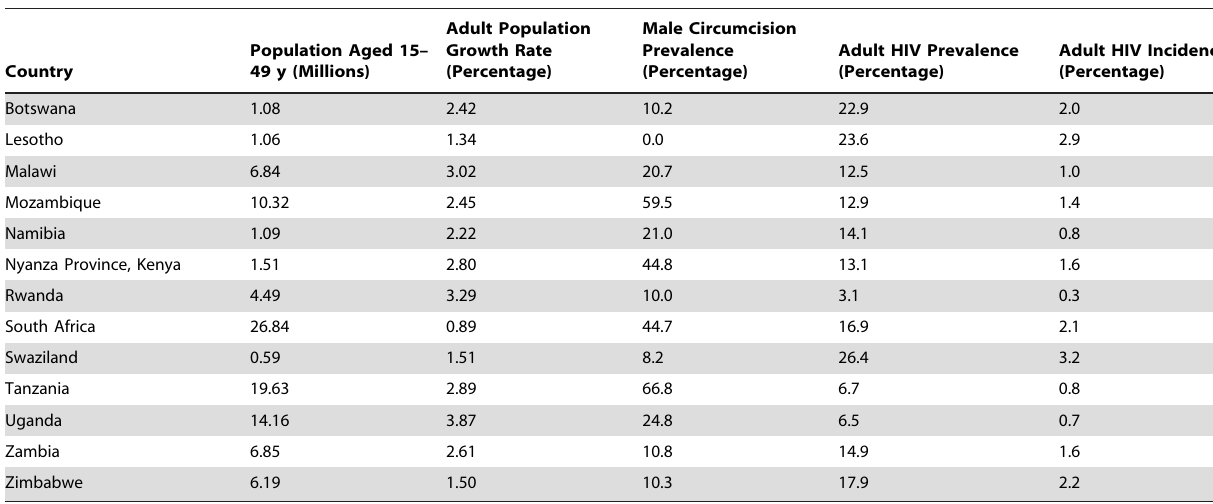
Table 1. Pre-scale-up population characteristics, by country.